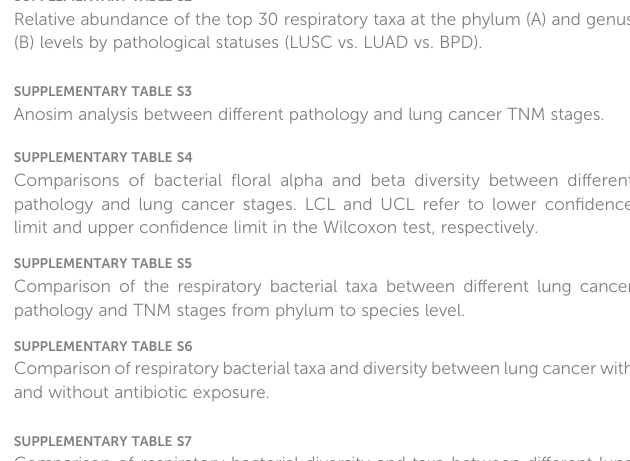
SUPPLEMENTARY TABLE S8 Comparison of respiratory bacterial taxa and diversity between lung adenocarcinoma with and without smoking history. Only one case in LUSC group had no smoking history, therefore bacterial taxa and diversity of smokers and non-smokers in LUSC group were not